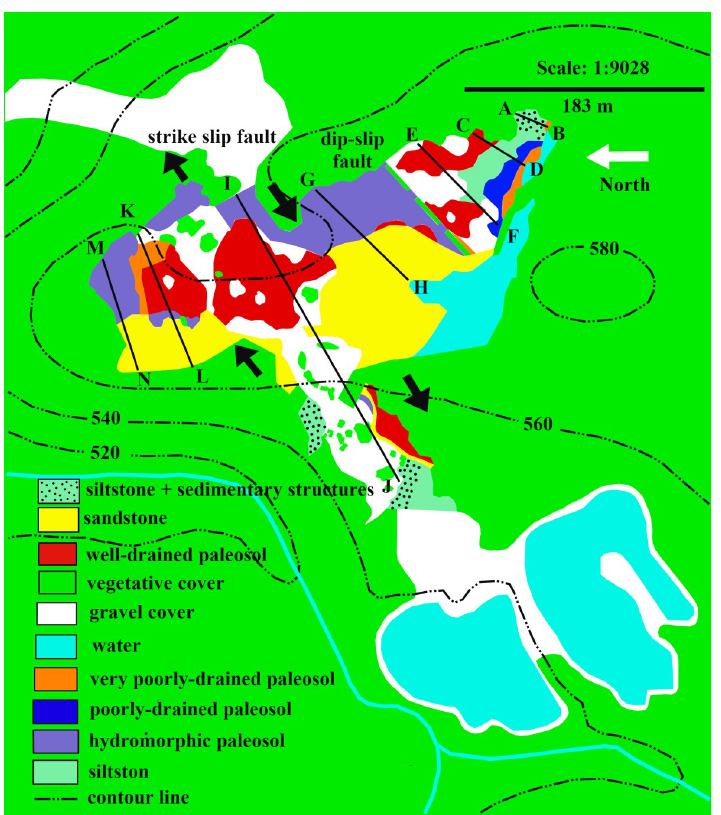
Fig 2. An aerial map of the sediment exposure at the TCHD. The aerial exposure map of the sediment exposures were drawn on a USGS base map. The planar exposure of the sediment deposits and covered areas are represented by different colors. Parallel cross-sections on the map were named alphabetically from south to the north of the quarry. The cross-section A-B located at the east-southeast, and the M-N at the north-northwest of the quarry floor. The Dip- slip fault was marked with a dashed line and the strike-slip fault with